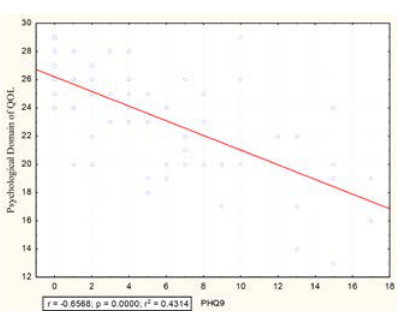
Figure 3. Correlation between psychologi- cal subdomain of the health-related quality of life and Patient Health Questionnaire nine-item